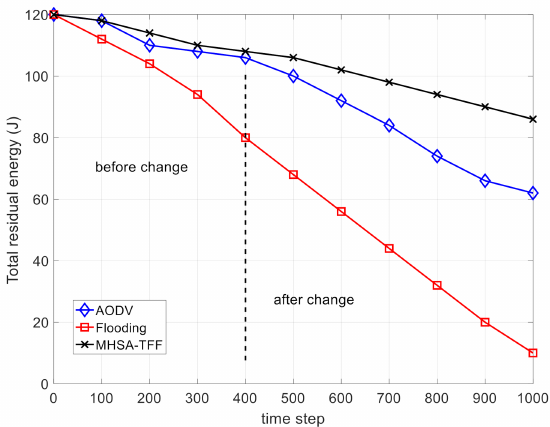
Figure 6. The comparison on the total residual energy.